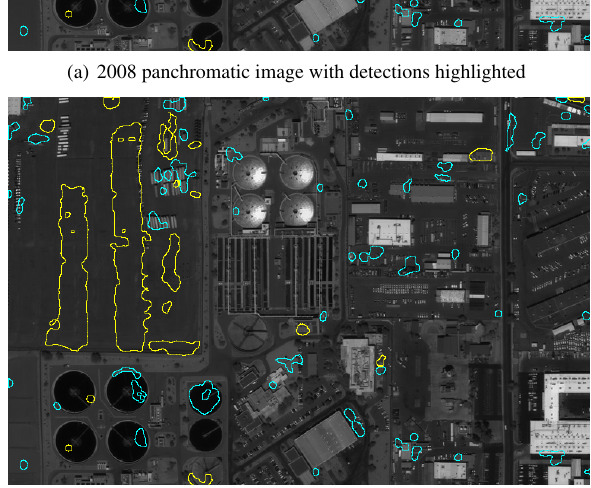
Figure 6: Result of the change detection over a part of the Phoenix area (cyan=constructions,